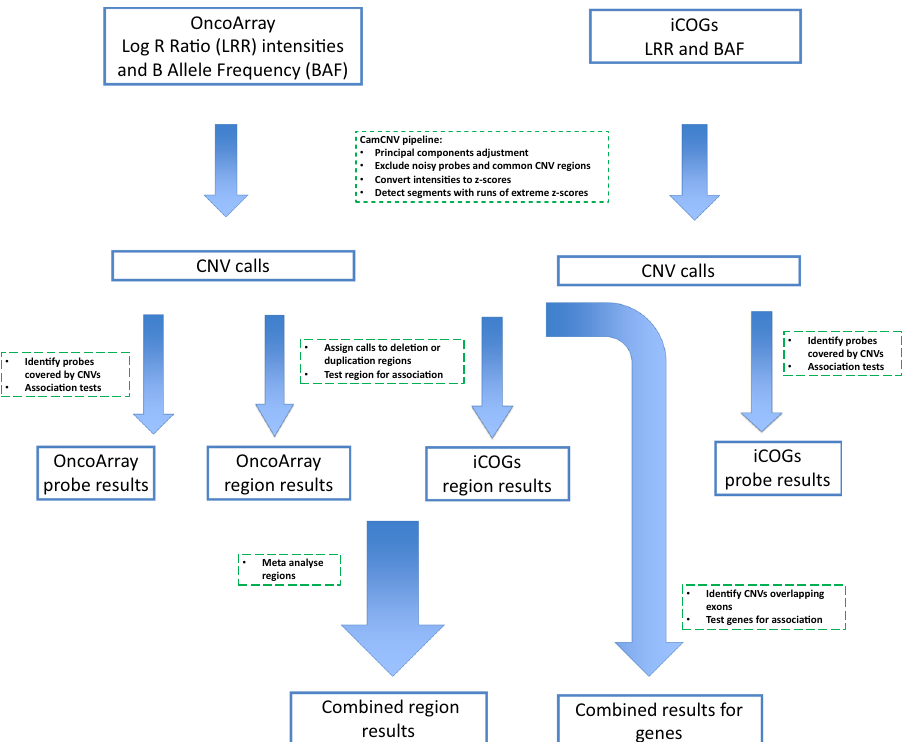
Fig. 1 Flow diagram of the calling and analysis pipeline. CNVs were called using the CamCNV pipeline from the intensities from the iCOGs and OncoArray genotyping arrays. The CNVs were assigned to regions, association results generated for each array and then meta-analysed. CNVs covering the coding regions of genes were analysed in gene burden tests.